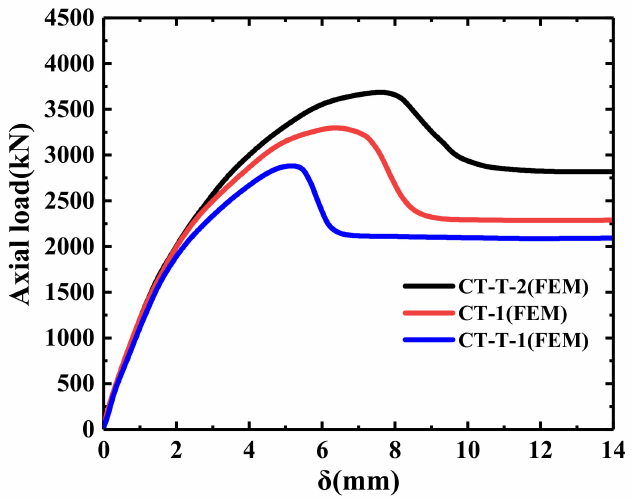
Figure 18. Load–displacement curve of members with different diameter-to-thickness ratios.